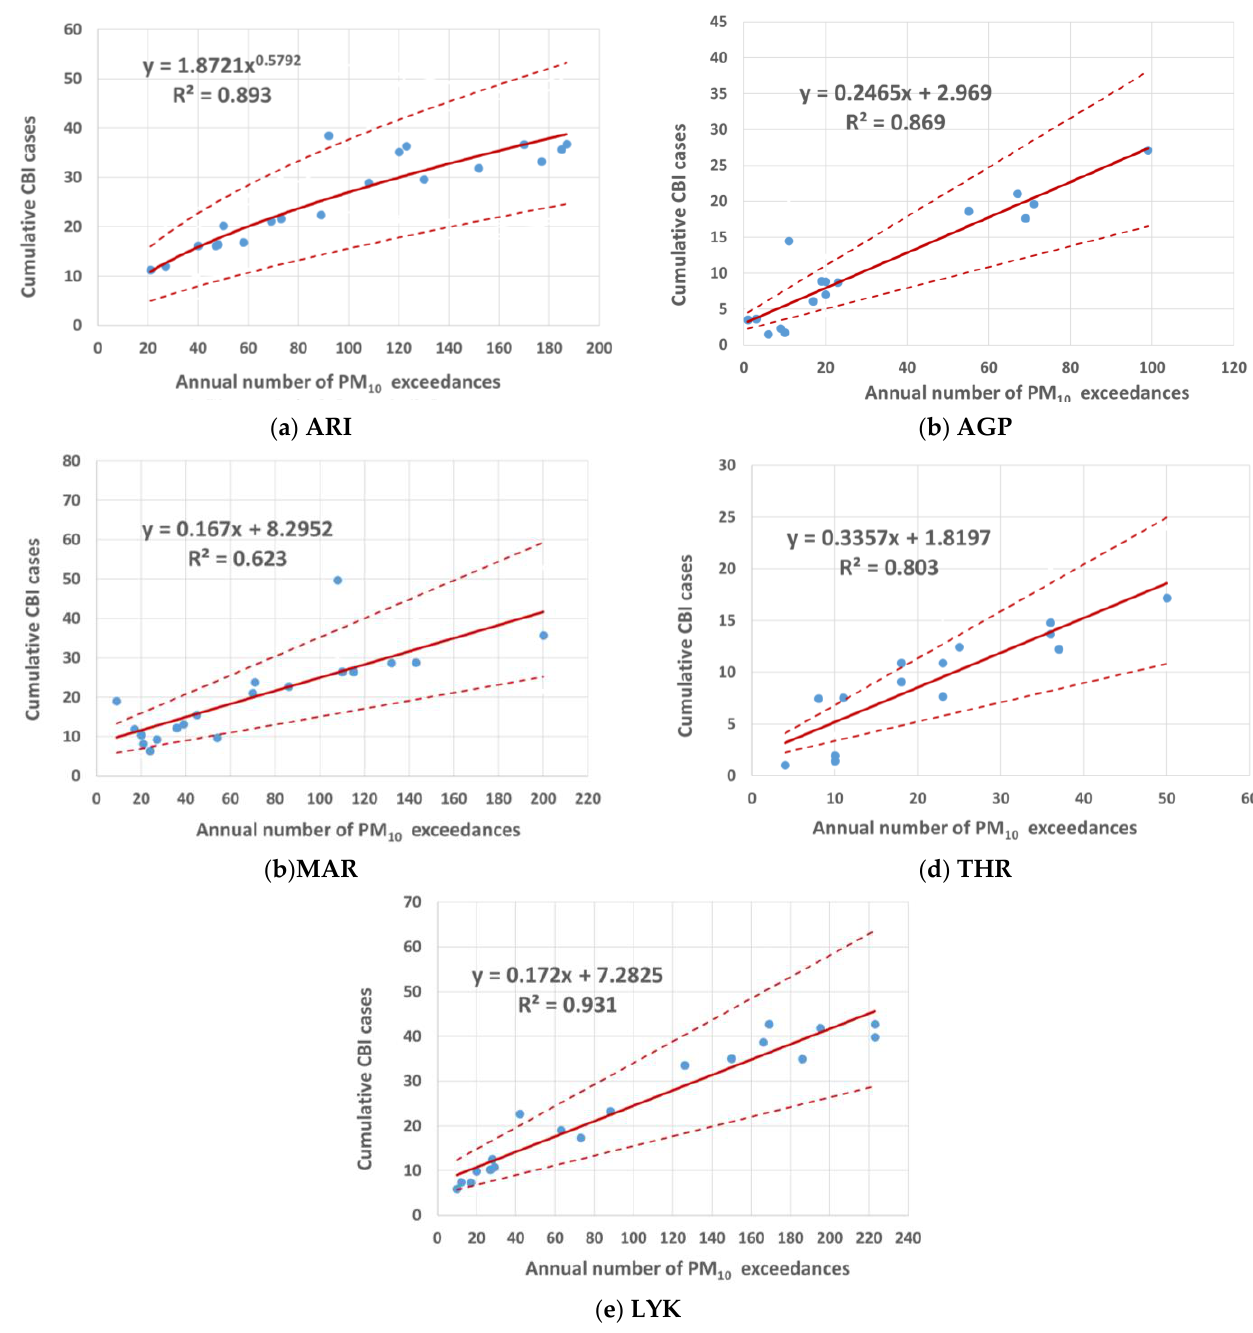
Figure 8. Annual variation in cumulative number of bronchitis incidents due to PM 10 exposure vs. annual number of PM 10 exceedances of all examined stations within the GAA. Period 2001 – 2020. (( a ): ARI, ( b ): AGP, ( c ): MAR, ( d ): THR, ( e ): LYK).